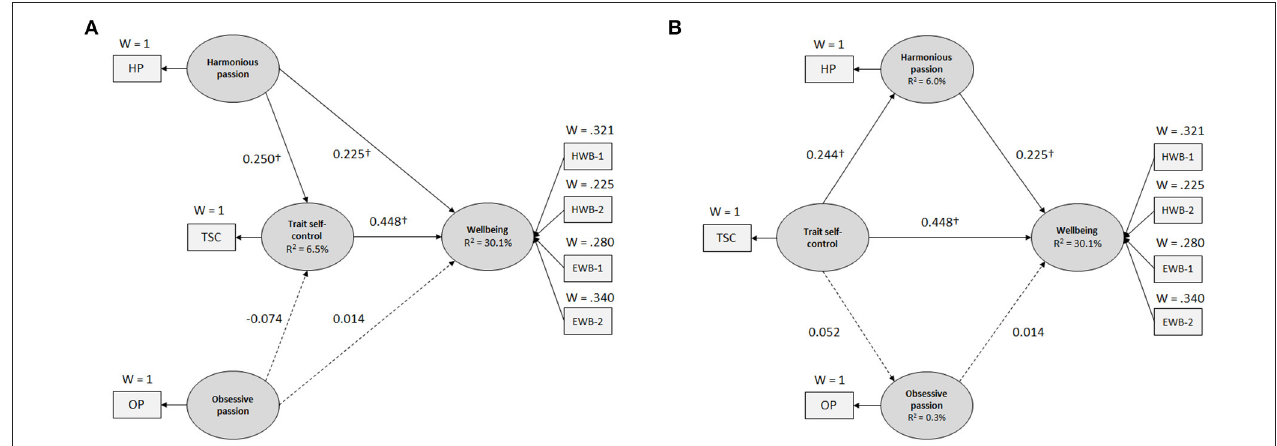
FIGURE 1 | Structural equation models: (A) model 1 and (B) model 2. All coefficients are standardized and solid lines indicate statistical significance. † p < .001 for a two-tailed test. HP, harmonious passion; OP, obsessive passion; TSC, trait self-control; HWB-1, happiness; HWB-2, satisfaction with life; EWB-1, vitality; EWB-2, eudaimonic wellbeing.